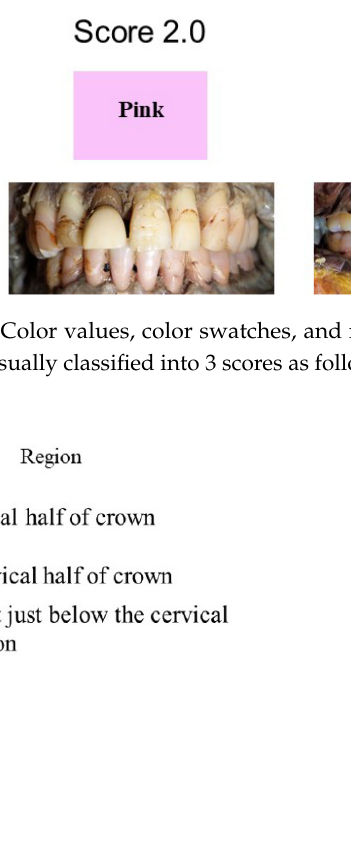
Figure 2. Score of Pink Teeth Regions diagram. The region of discoloration was visually classified into 3 scores as follows: root just below the cervical region, 1.0; cervical half of the crown, 2.0; and incisal half of the crown, 3.0.